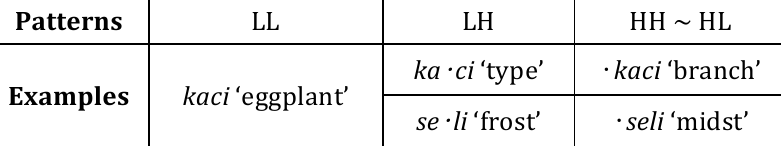
Table 7: Middle Korean tones in disyllabic nouns (H = high tone, L = low